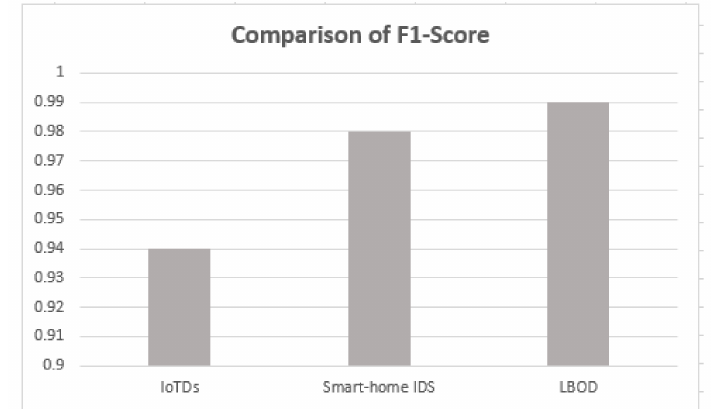
Figure 12. Comparison of